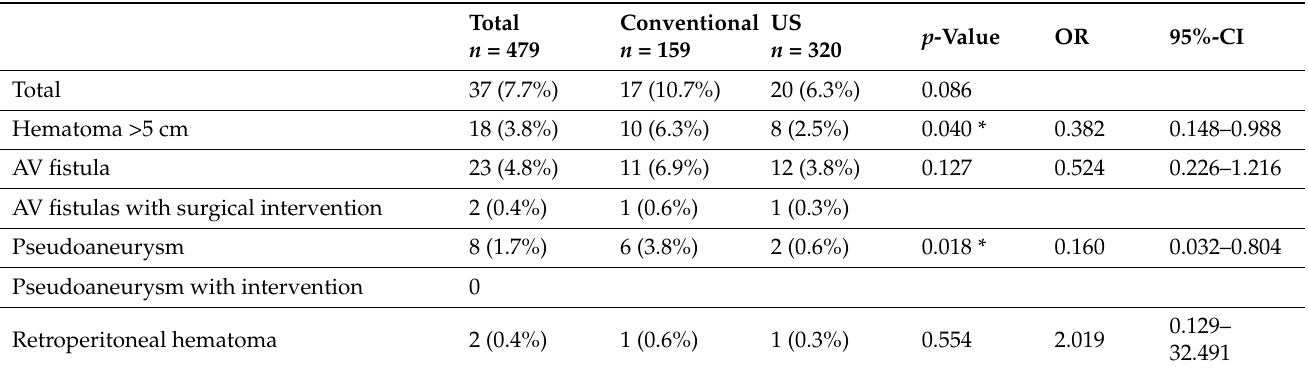
Table 5. Primary endpoint results: Peri-/postprocedural vascular access complications within 48 h post-procedure and risk reduction by US.